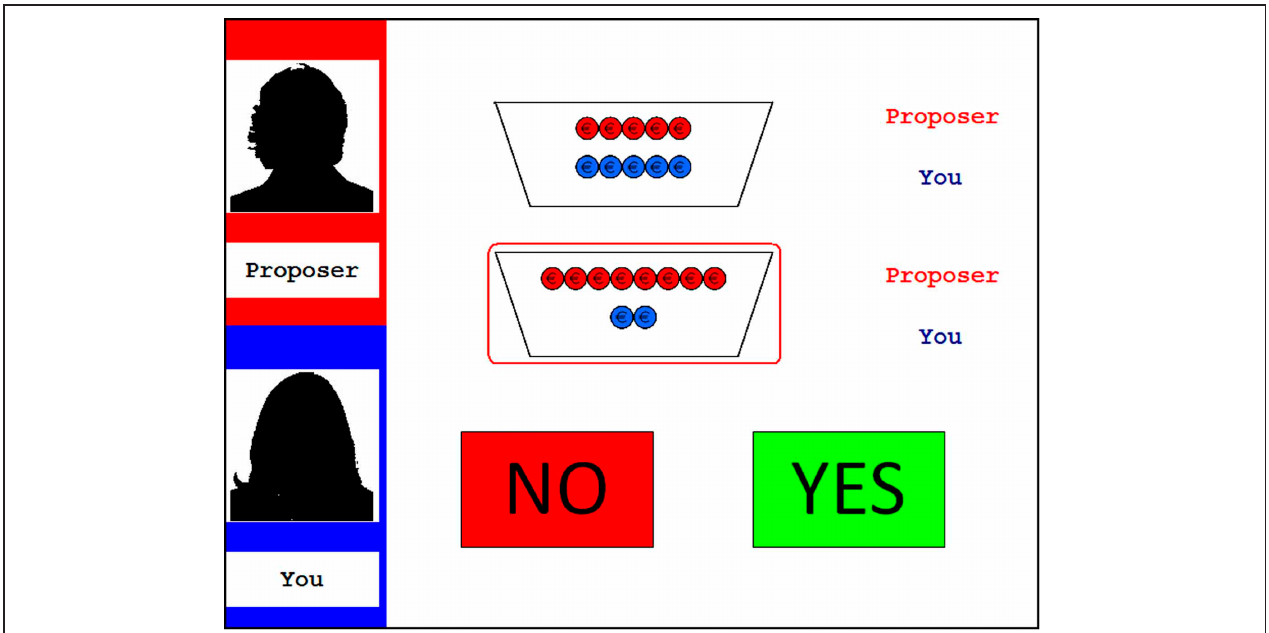
specified by red and blue coins (red for the proposer, blue for the responder; here 8:2 vs. 5:5). The selected offer is encircled in red. The participant has to decide whether to accept (“Yes”) or reject (“No”) the offer via button